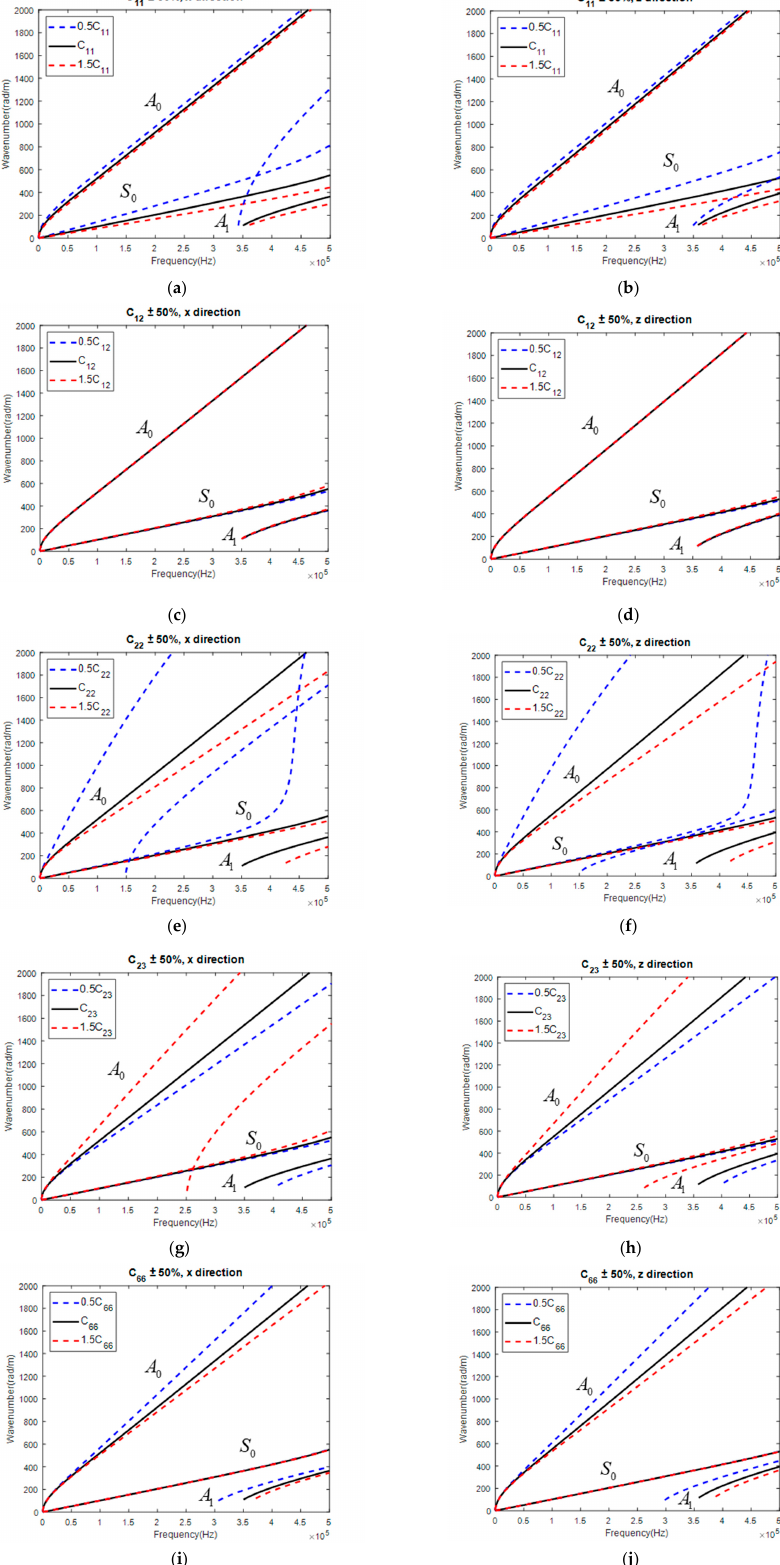
Figure 7. Influence of parameter on GW dispersion curve in CP: C 11 on GW along ( a ) x and ( b ) z direction; C 12 on GW along ( c ) x and ( d ) z direction; C 22 on GW along ( e ) x and ( f ) z direction; C 23 on GW along ( g ) x and ( h ) z direction; C 66 on GW along ( i ) x and ( j ) z